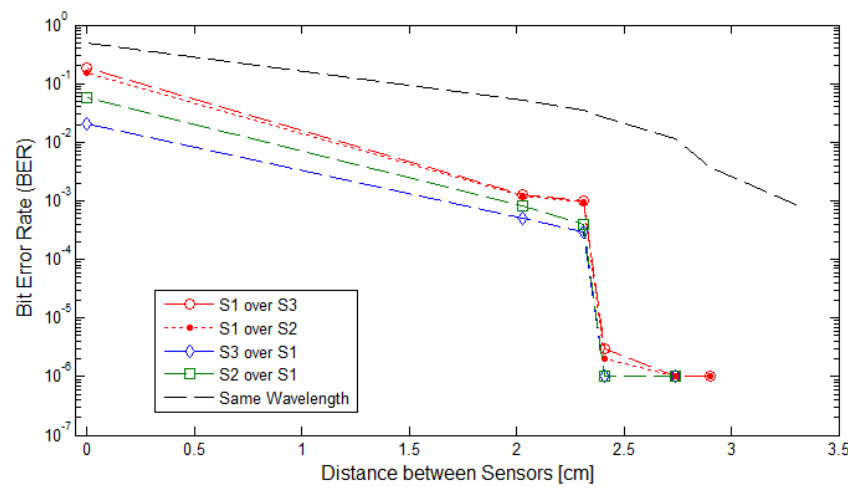
Figure 20. Monte Carlo Simulation. Bite Error Rate in function of the separation between sensors. The sensors transmitted On-Off Keying (OOK)-NRZ . signals in Red (S1), Green (S2) and Blue (S3). Results of the second wireless sensor network simulation are shown in Figure 21.